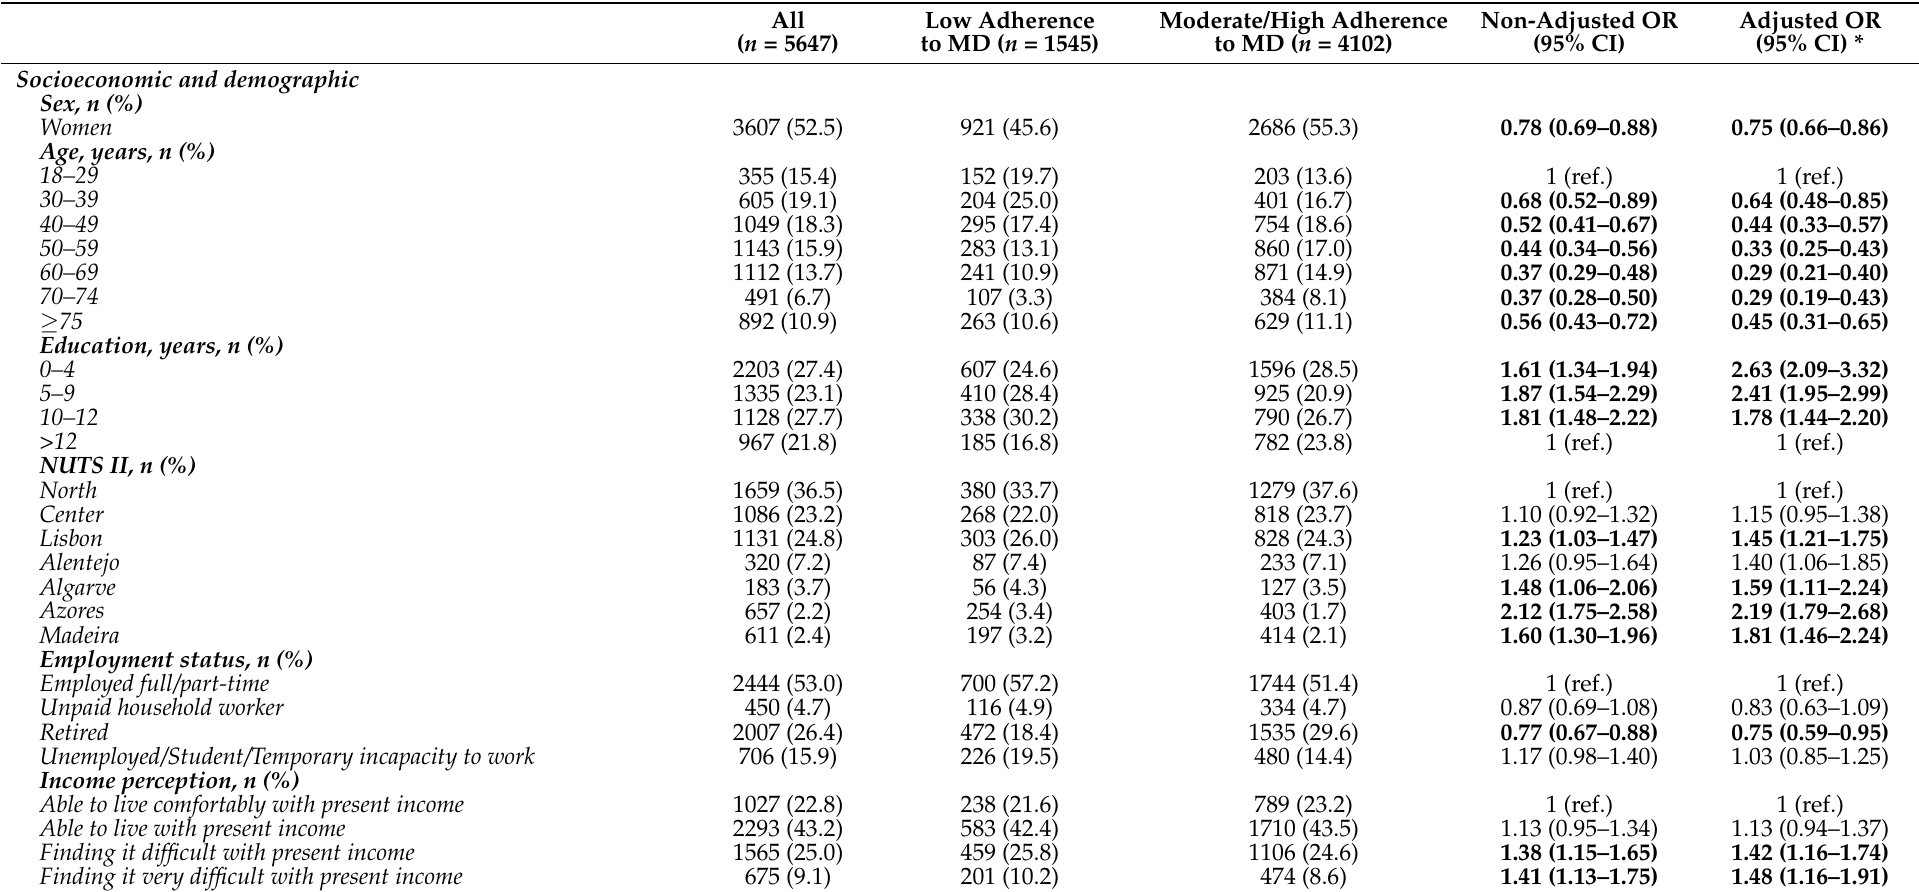
Table 1. Sociodemographic, socioeconomic, lifestyles and health characteristics of individuals with low and moderate/high adherence to the Mediterranean diet (MD), and logistic regression models for the odds of having low adherence vs. moderate/high adherence to the